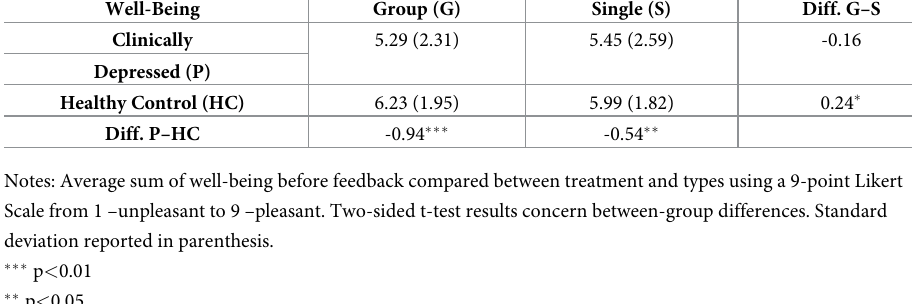
Table 14. Well-being before feedback.